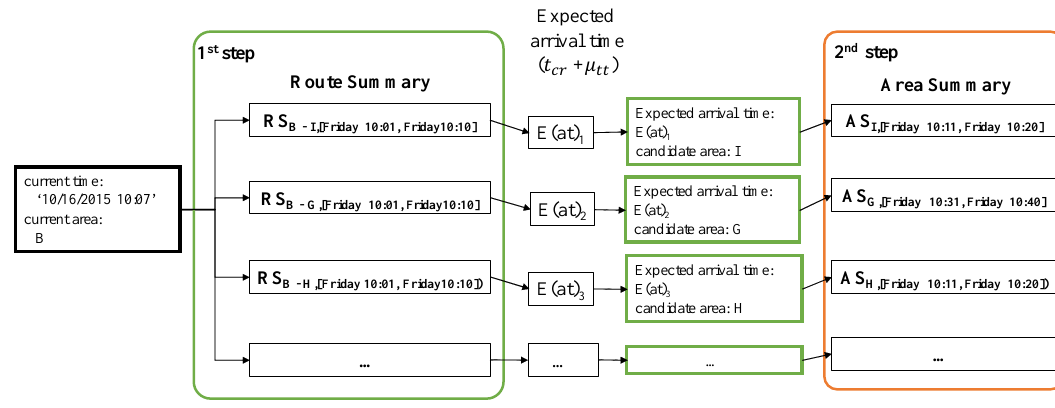
Figure 9. Two steps for constructing a profitable area map.